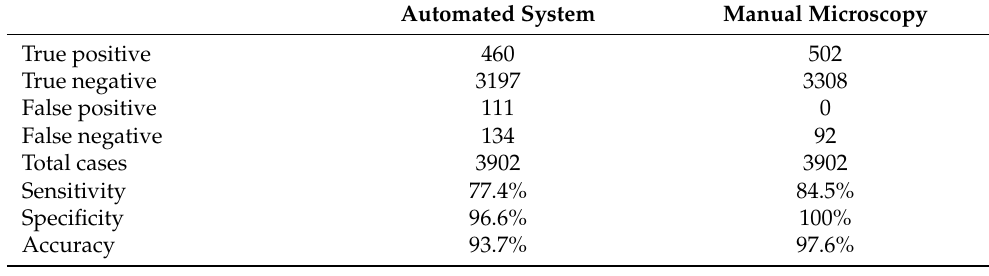
Figure 4. The two false-positive cases due to the poor smear staining quality.